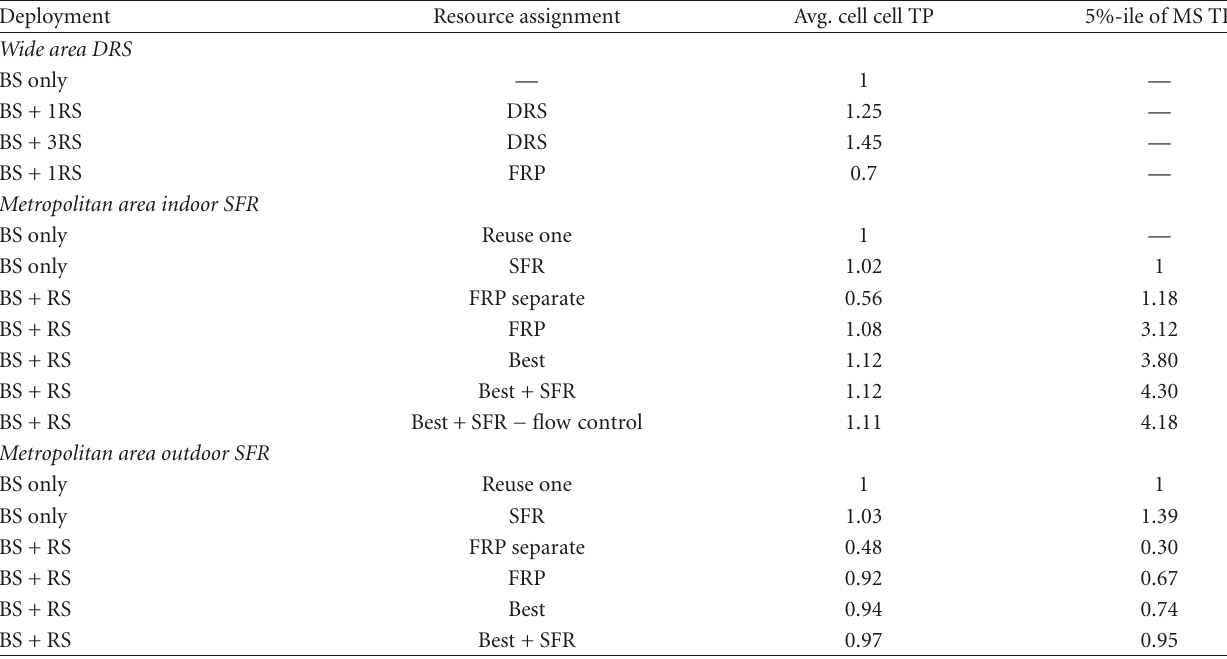
Table 3: Relative performance of BS only and RS deployment with di ff erent resource assignment options in the test scenarios.